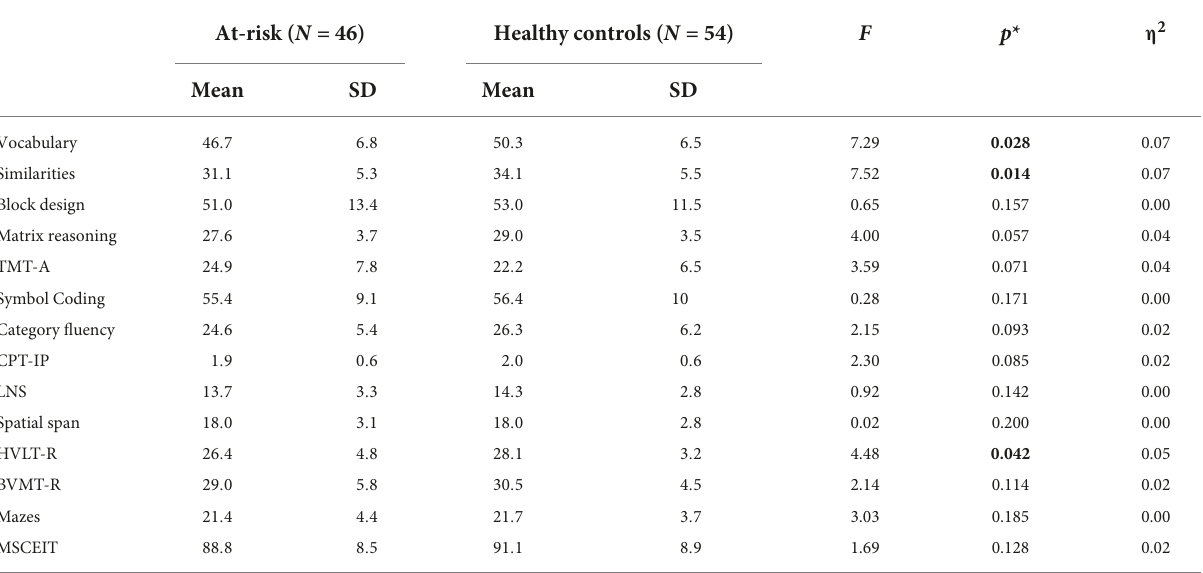
FIGURE2 MCCB (mean, SD).